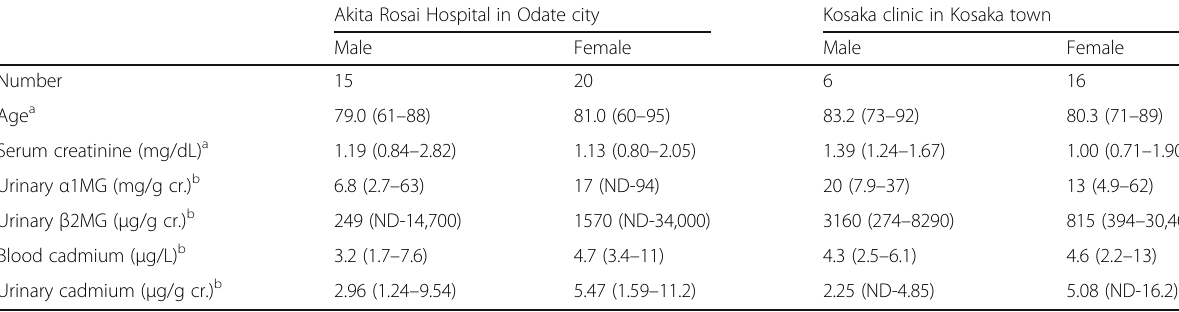
Table 1 Subject profiles in two medical institutes